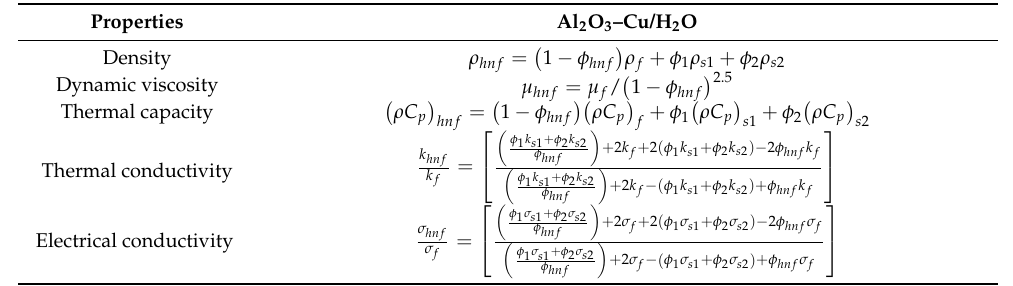
Table 2. The alumina–copper/water (Al 2 O 3 –Cu/H 2 O) correlation coefficient (Takabi and Salehi [43]; Ghalambaz et al.